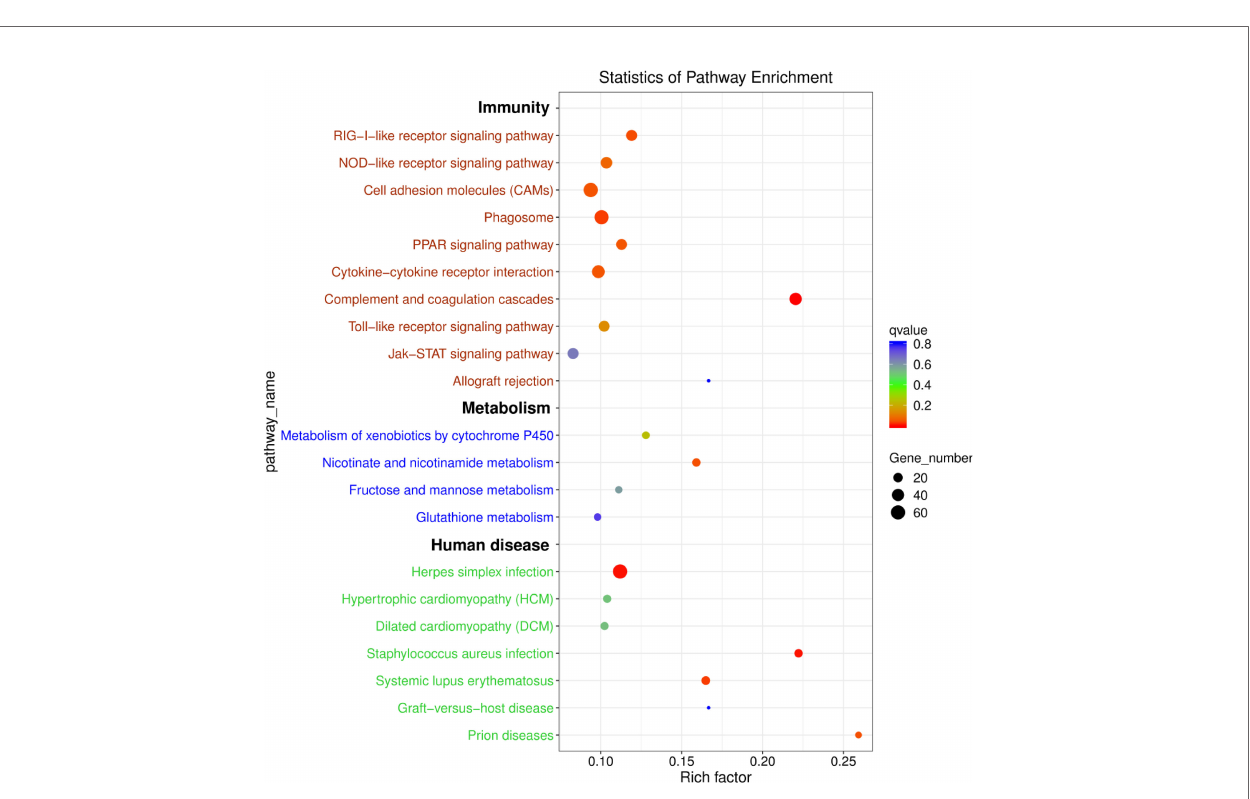
FIGURE 5 | KEGG enrichment diagram of DEmRNAs between WR_S and YR_S groups. The x-axis represents the rich factor, the y-axis represents different pathways. Different colours of plots indicate different q values. The plot diameter represents the number of DEmRNAs in a